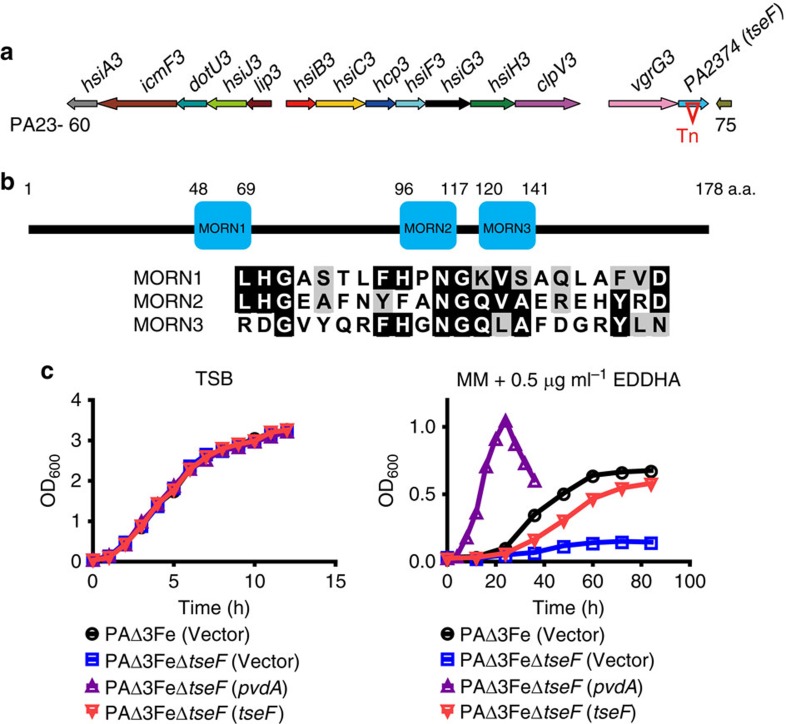
A gene proximal to H3-T6SS is required for the growth of a mutant missing known iron acquisition systems.(a) The organization of H3-T6SS and its neighbouring genes. Structural genes are depicted as colour arrows that indicate the transcriptional directions. The gene numbers are only indicated at the end of the cluster. Gene PA2374 (tseF) identified in the screening is marked by an inverted triangle, indicating transposon insertion. (b) Domain structure of TseF. The positions and regions of the predicted membrane occupation and recognition nexus motifs are shown. (c) The growth of the mutants in iron-deficient media. Relevant bacterial strains were grown in TSB or succinate MM containing EDDHA (0.5 μg ml−1). Cell growth was monitored by measuring OD600. Note that the deficiency of growth by mutant PAΔ3FeΔtseF in iron-deficient media can be restored by expressing either pvdA or tseF. The curves represent three biological replicates; error bars are s.d.